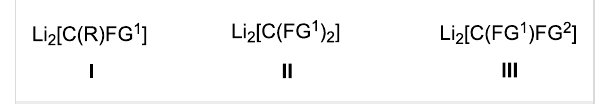
tivity studies of 2 with carbon and metal-based electrophiles revealed a high synthetic potential, allowing, for example, the synthesis of carbo- and heterocycles [4,6], and transition-metal carbene complexes [1,2], carrying the synthetically versatile sulfonyl group